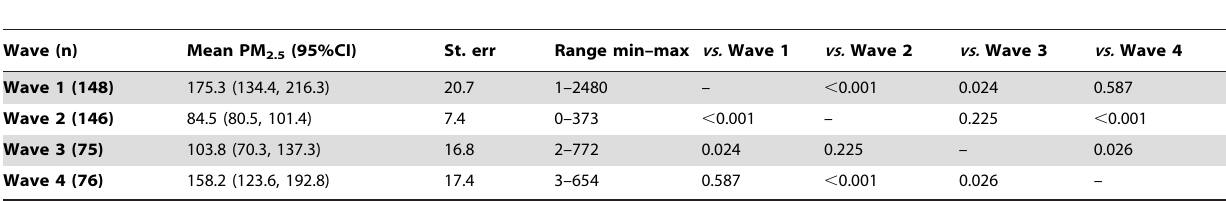
Table 2. Temporal trends in mean indoor PM 2.5 measurements ( m g/m 3 ) and unadjusted pair-wise comparisons between Waves of the Hellenic Air Monitoring Study, Greece 2010–2011.